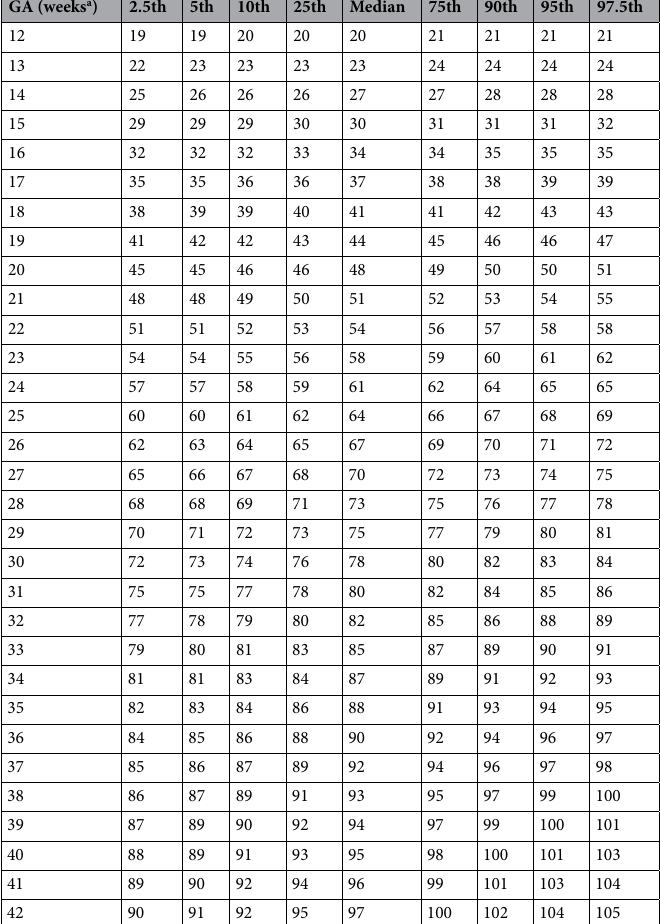
Table 3. Estimated biparietal diameter (BPD) in mm by gestational age (GA) for males and females, percentiles. a GA expressed as completed gestational weeks, e.g. 12 weeks corresponds to 12 + 0 weeks or 84 gestational